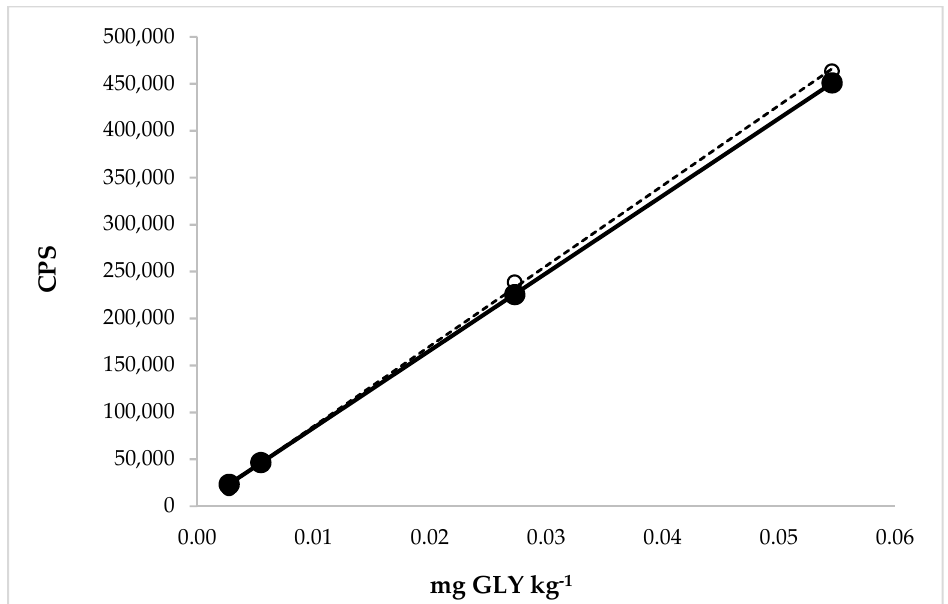
Figure 4. Comparison between the calibration curves of GLY in the extraction solution (dotted line) with linear equation y = 8.543 × 10 6 x − 244.4 and regression fit 0.999 and in the extraction solution with the matrix (white rice, solid line) with linear equation y = 8.240 × 10 6 x + 1100 and regression fit 1.000.